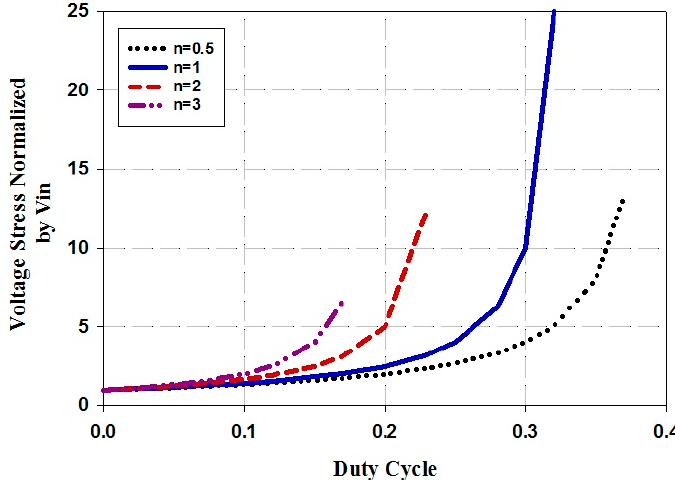
Figure 8. Voltage stress of the switch for different turn ratios of coupled inductors.